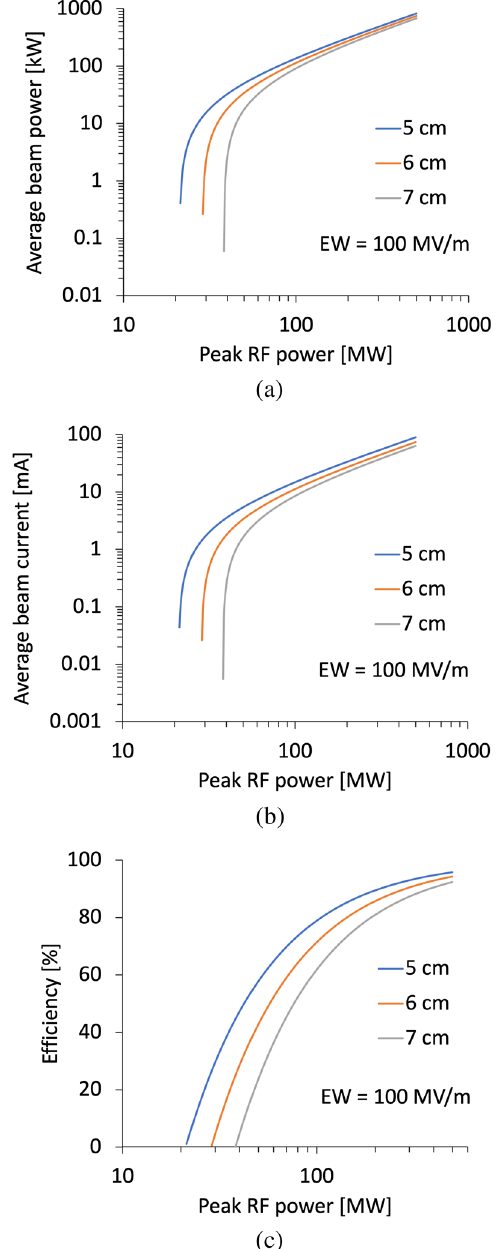
FIG. 11. Similar to Fig. 10, except for peak wall fields of 100 MV = m. For these cavities, accelerations up to 9.7, 10.2, and 10.7 MeV, respectively, are